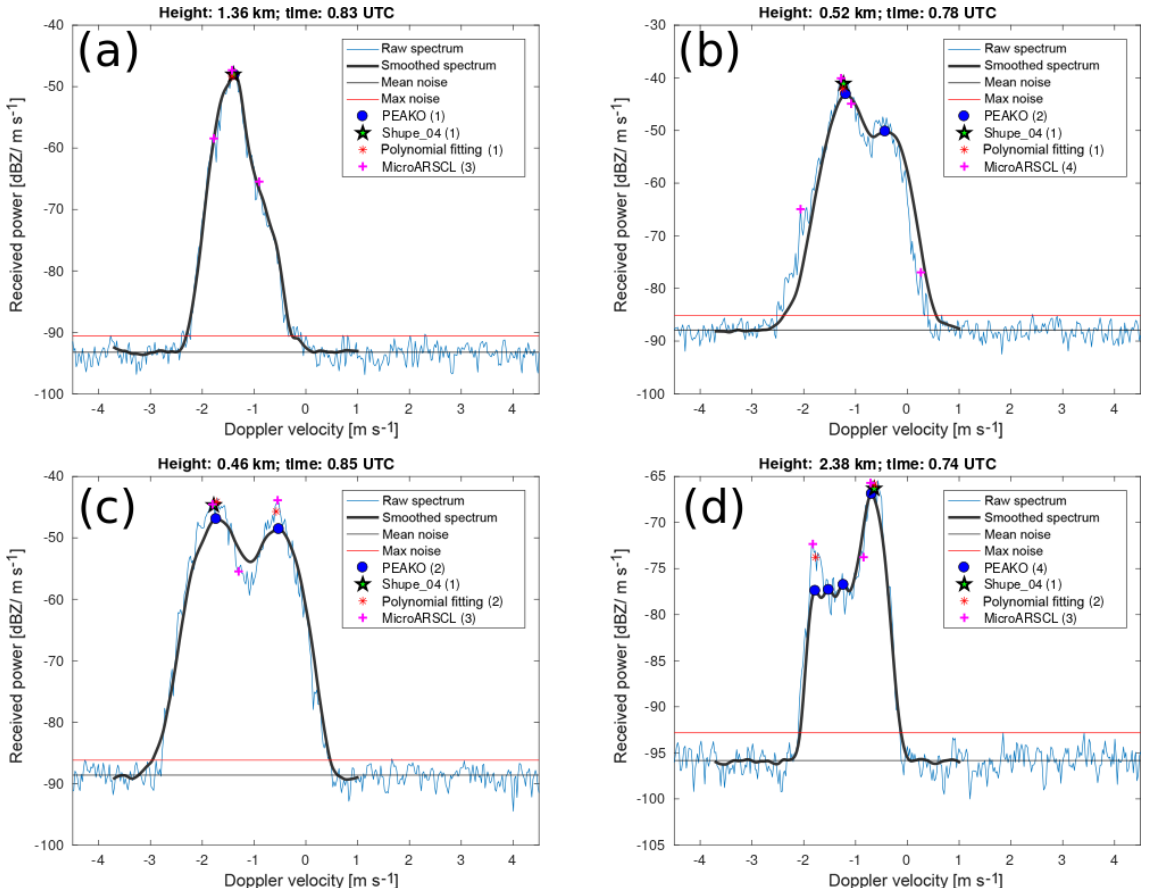
Figure A4. Four example spectra selected from the case study on 16 February 2014, 0.63–0.92UTC. Please note that the y axis scale is different for each of the spectrum